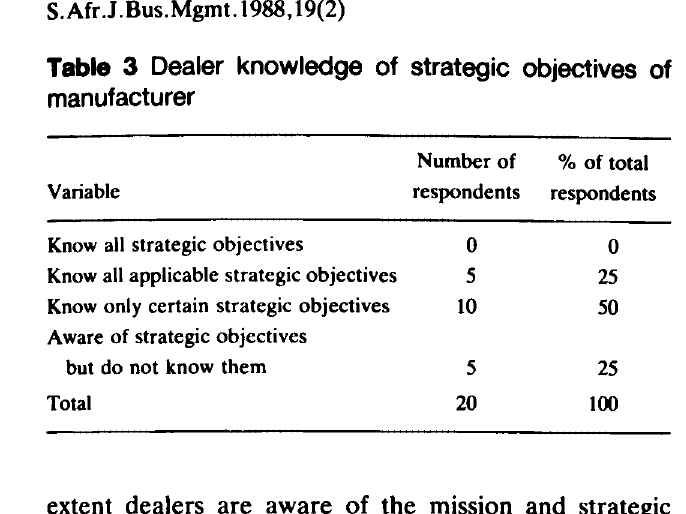
Table 5 The nature of the objectives of dealers• Number of % of